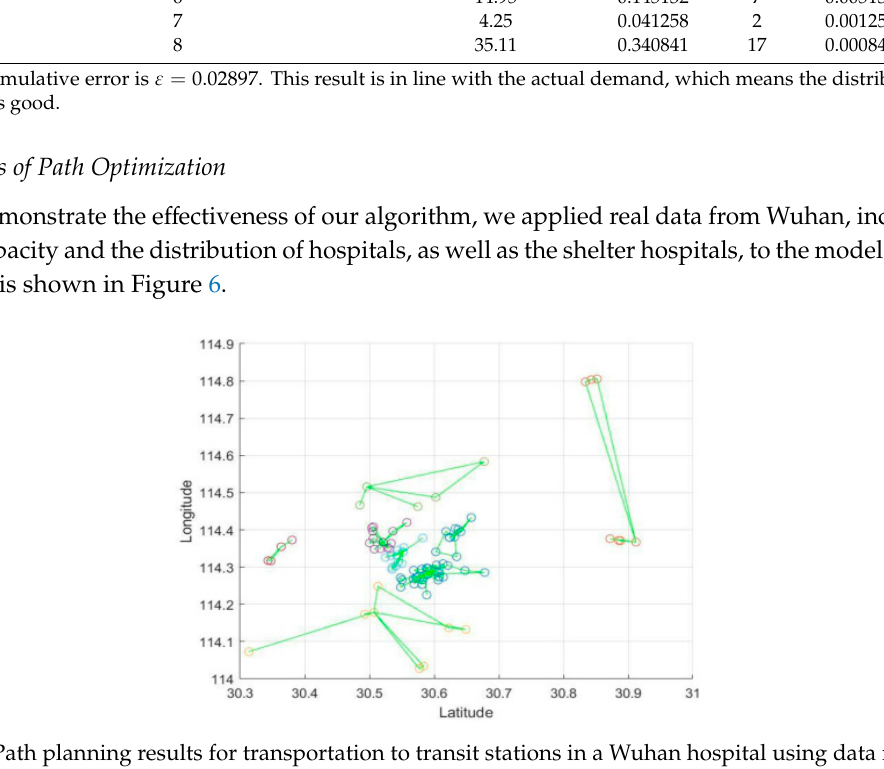
Figure 6. Path planning results for transportation to transit stations in a Wuhan hospital using data modeling.